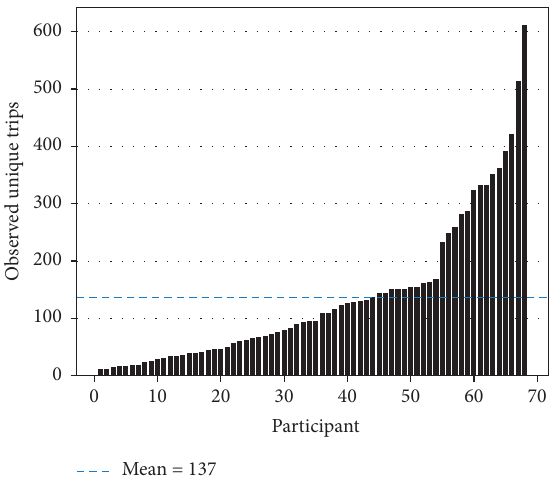
Figure 22: Share of unique trips among active participants.